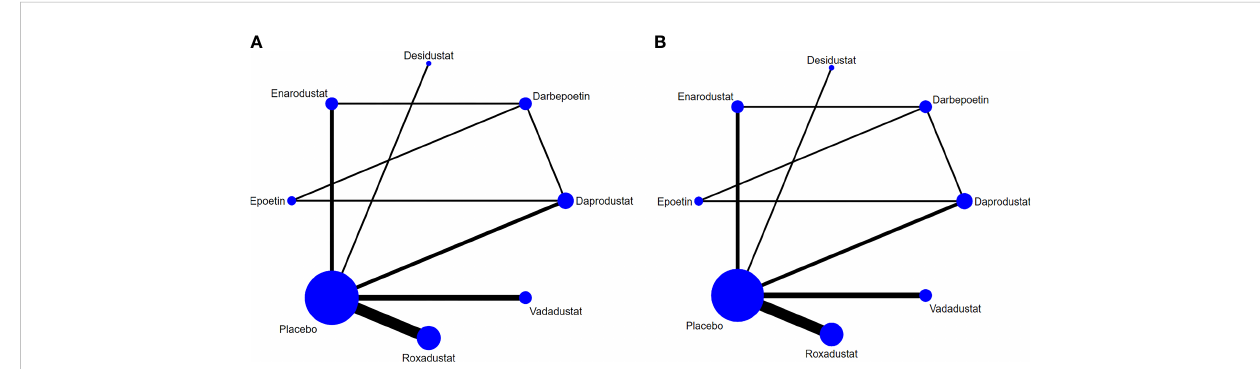
FIGURE 4 Network graphs of all the drug agents included in the study. The width of the lines is proportional to the number of trials comparing each pair of treatments. The sizes of the circles are proportional to the number of trials using this intervention. (A) hepcidin, (B)